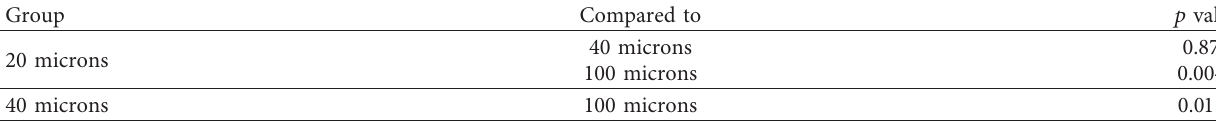
Table 1: Post hoc comparisons of study groups regarding µ SBS.